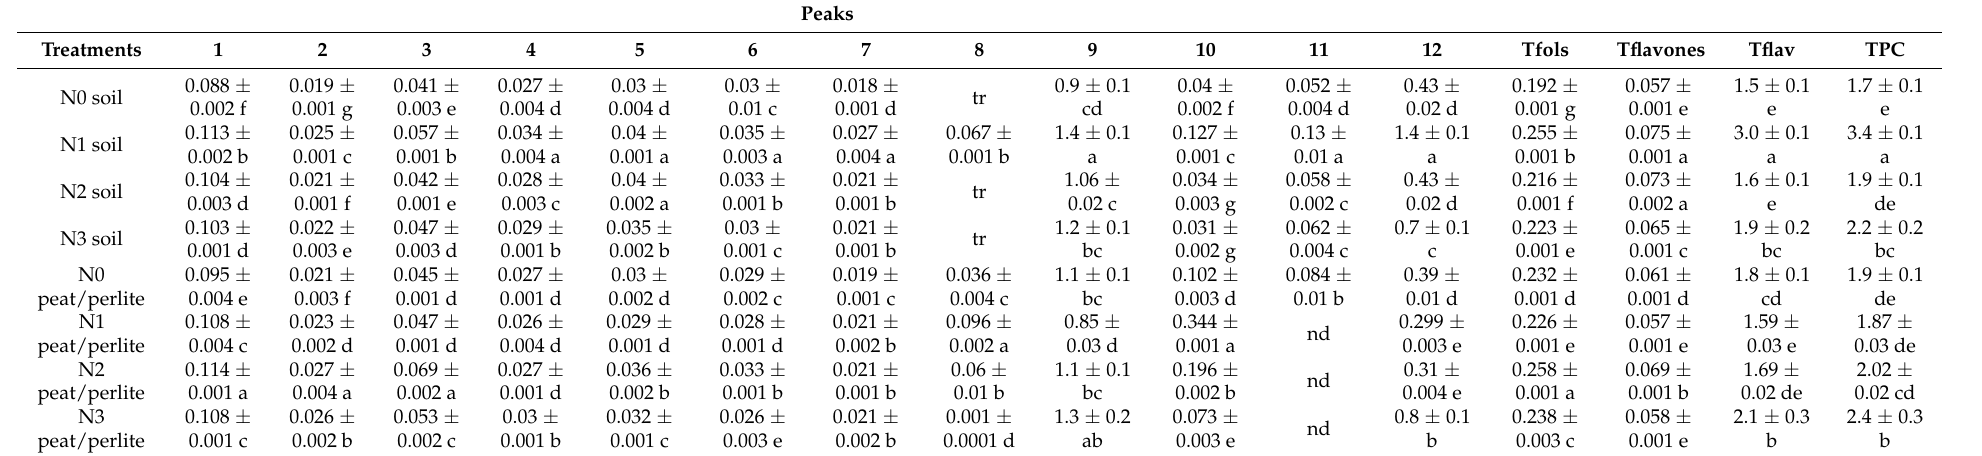
Table 4. Quantification (mg/g of plant fresh weight (fw)) of the phenolic compounds present in the extracts of Centaurea raphanina spp. mixta plants in relation to nitrogen fertilization and growth substrate (mean ±